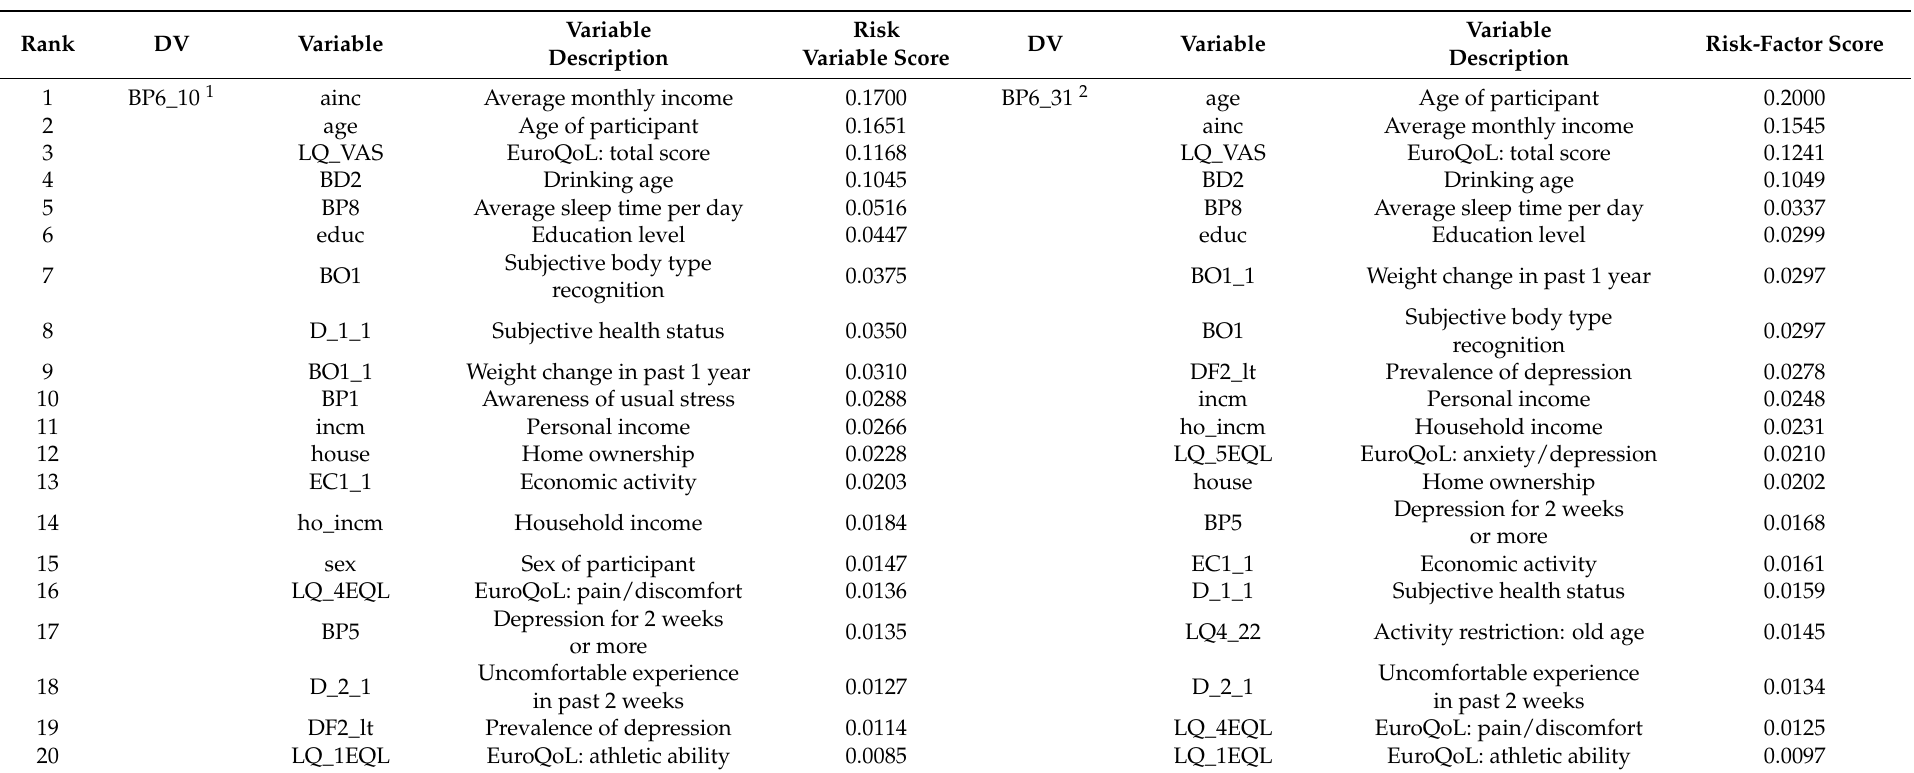
Table 9. Important features and risk-factor score in yearly dataset condition